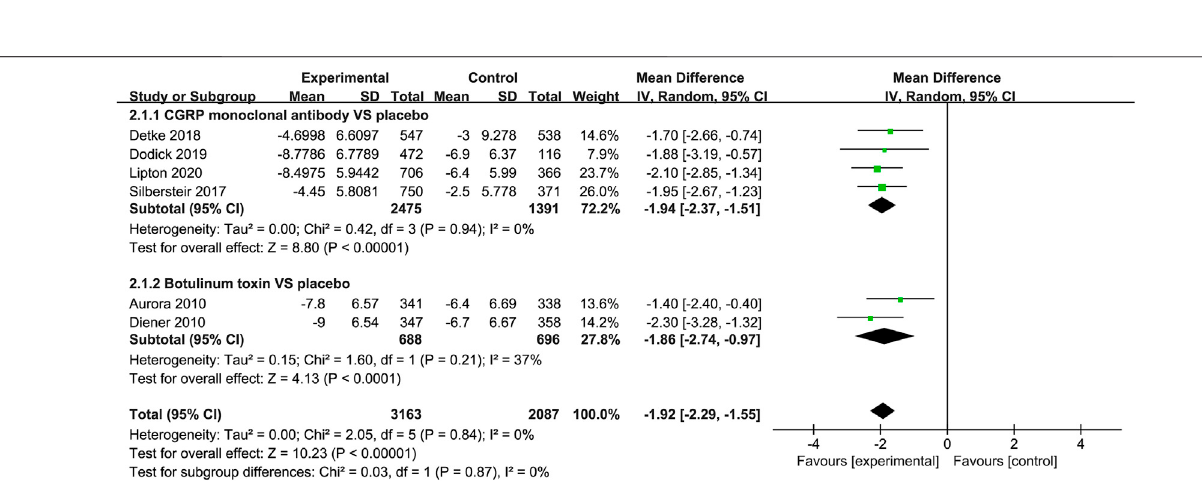
Frontiers in Pharmacology |